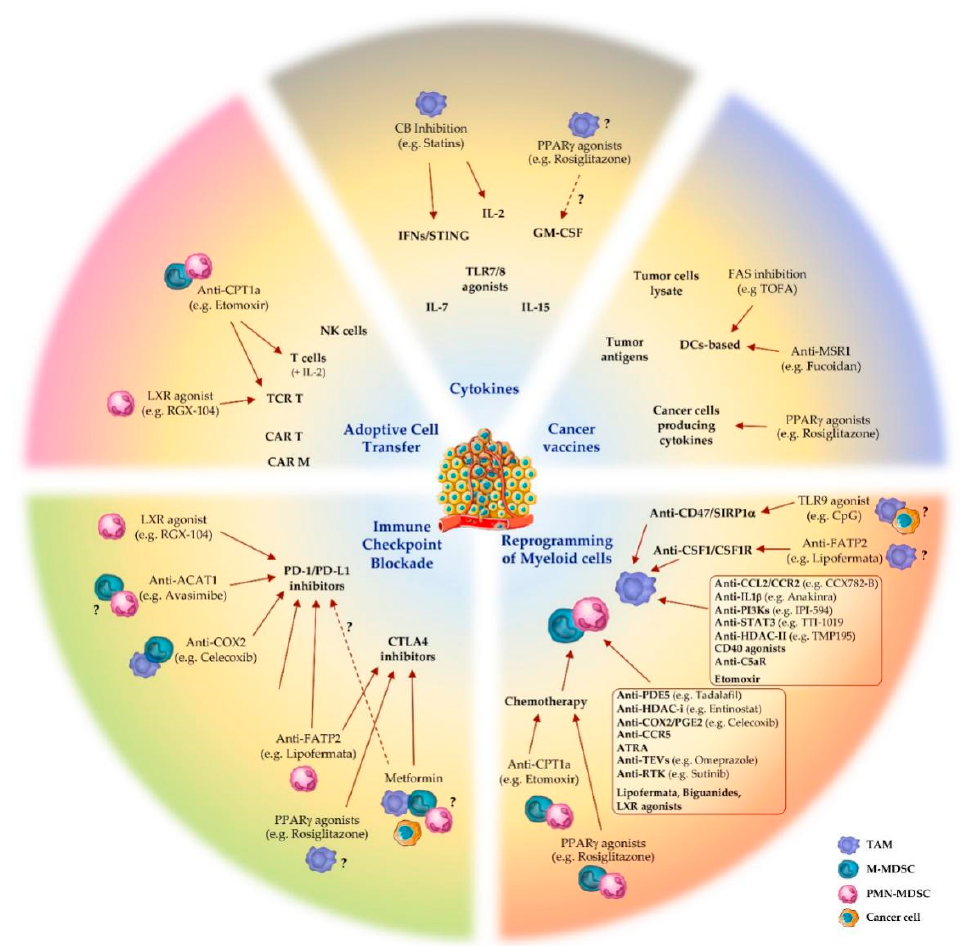
Figure 1. Targeting lipid metabolism of myeloid cells in cancer immunotherapy. Pharmacological modulation of molecular regulators of lipid metabolism in tumor-associated macrophages (TAM), monocytic (M-) and granulocytic (PMN-) myeloid-derived suppressor cells (MDSC) showed efficacy in dampening tumor immunosuppression and improving cancer immunotherapies: immune checkpoint blockade; adoptive cell transfer; cytokines administration or modulation; cancer vaccines; reprogramming of polarized inflammation in myeloid cells. Abbreviations: LXR, liver X